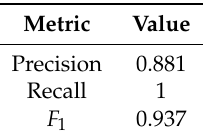
Table 5. Method II: Glomerulus detection. Quantitative